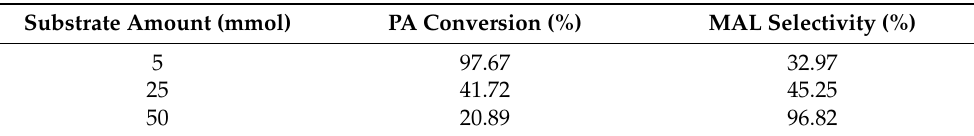
Table 4. Results of the aldol condensation reaction with Mg 3 Al–Pro-LDHs catalysts at different substrate